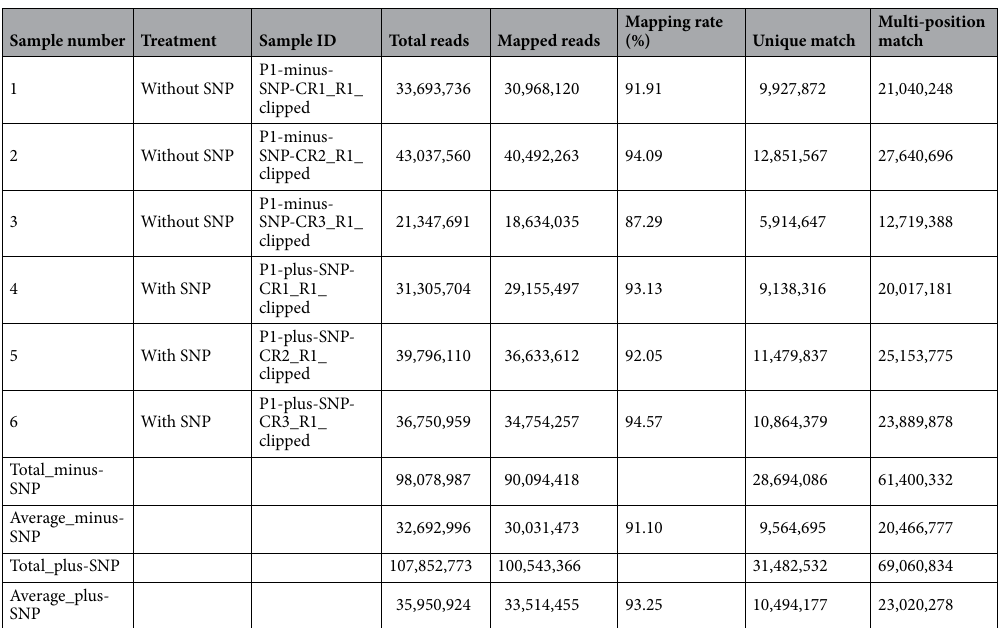
Table 1. Mapping statistics of RNA-Seq. Samples represent three SNP-treated and three untreated control.